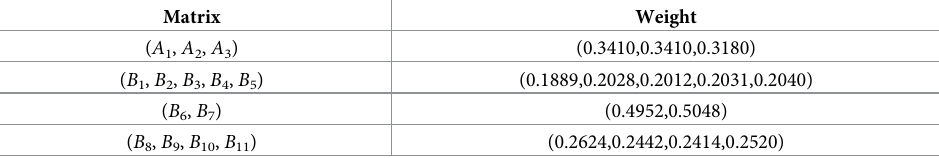
Table 10. Normalized weight vector of performance evaluation index.